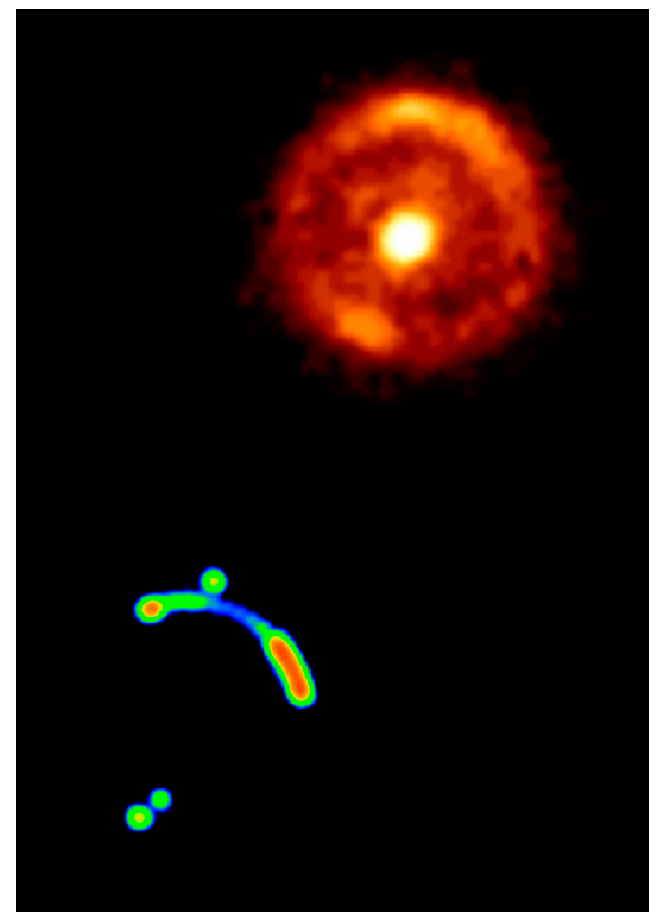
Figure 17. ( Upper ) The Hubble Space Telescope picture of the distant galaxy 1938+666 which has been imaged into an Einstein ring by an intervening galaxy. The intervening galaxy shows up as the bright spot in the center of the ring. The picture was taken in the infrared region of the spectrum and the computer-generated color of the image has been chosen simply for ease of viewing. ( Lower ) The MERLIN radio picture of the radio source 1938+666 embedded in the distant galaxy. The incomplete ring (or arc) shows that the radio source is not perfectly aligned with the lens galaxy and the Earth. The lens galaxy does not contain a radio source and hence does not show up in this picture. The colors are computer-generated and represent different levels of radio brightness. Credit: Neil Jackson, http://www.merlin.ac.uk/press/PR9801/press.html.